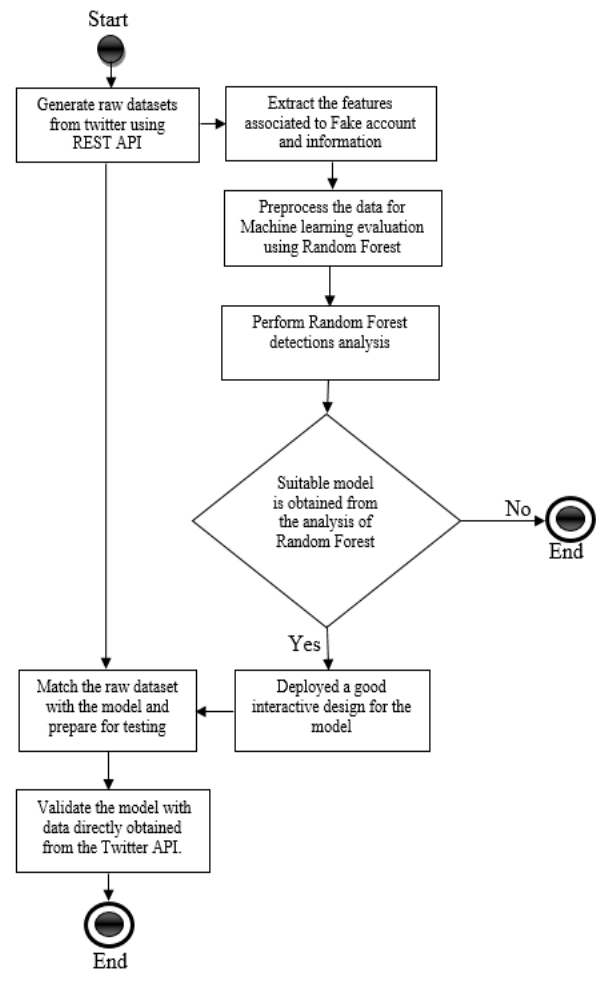
Figure 1. The flowchart of the methodological approach.